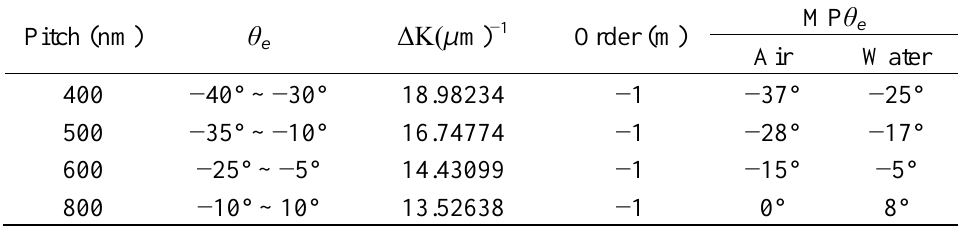
with maximum emission intensity (MP θ